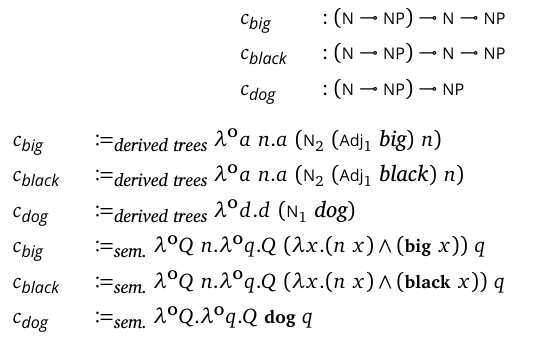
(cid:6) derivations